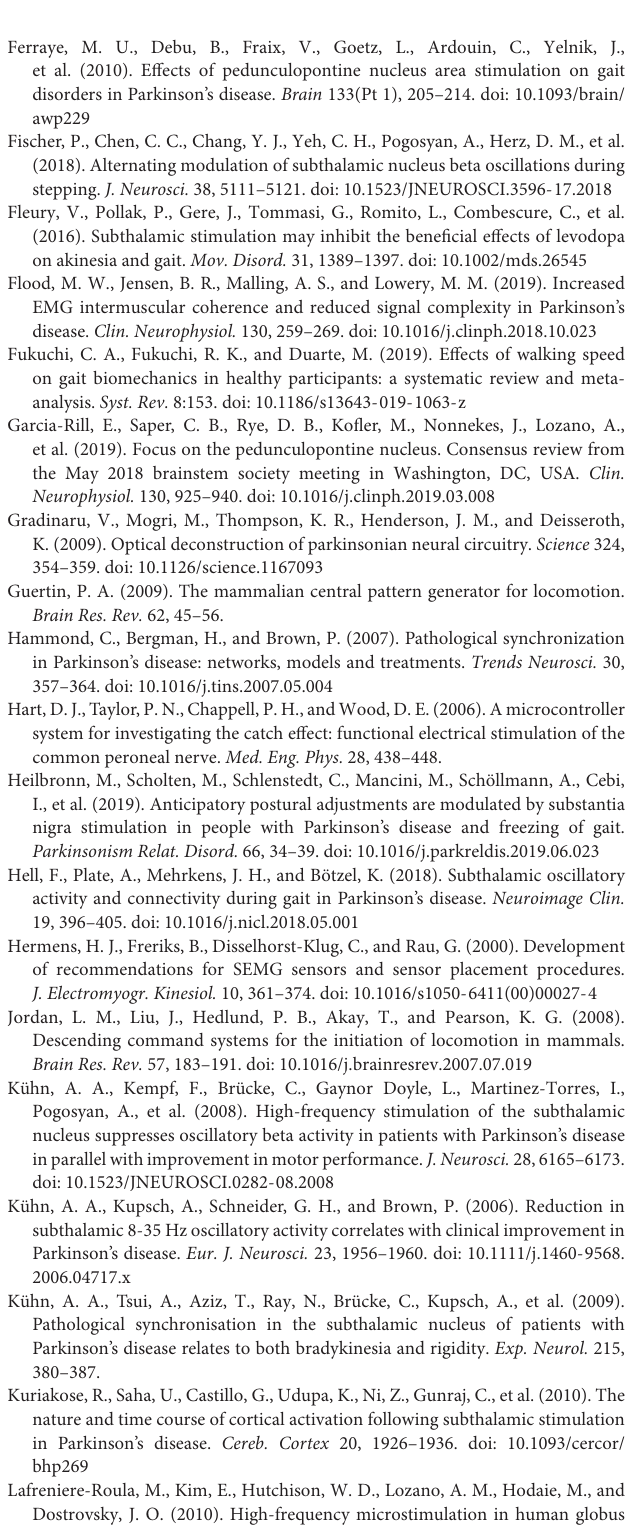
Supplementary Figure 1 | Power spectrum and standard error of the mean (SEM) of TA (left panel) and GA (right panel) during ‘regular gait’ in 9 PD patients with DBS turned off (‘StimOff’) and healthy controls (HC) after band pass